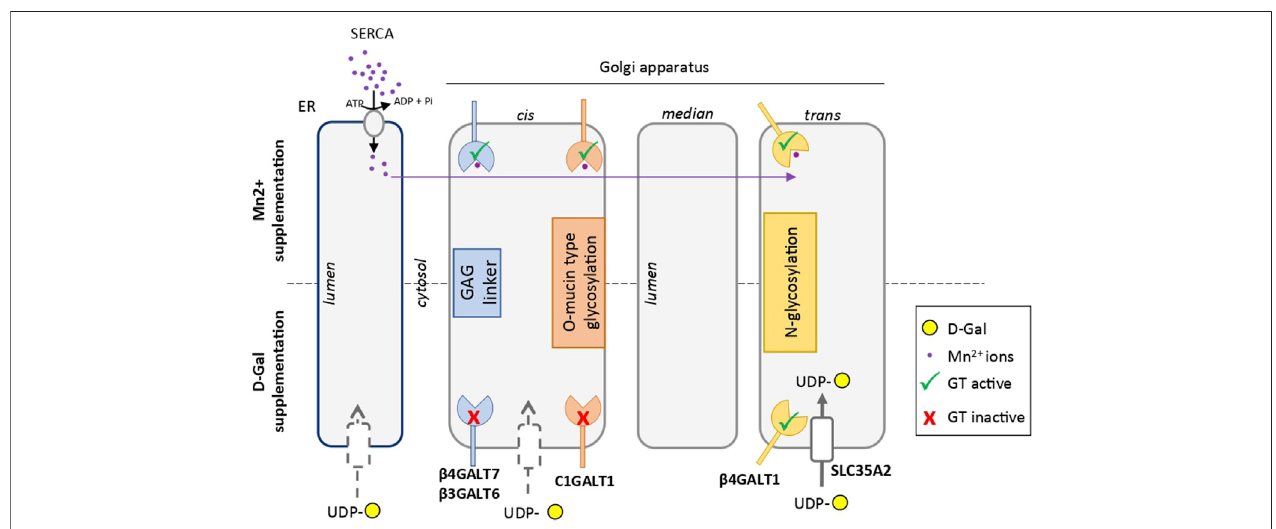
FIGURE 7 | Scheme comparing the hypothetical mechanisms involved in the rescue of glycosylation induced by Mn 2+ and D-galactose in TMEM165 KO cells. Endoplasmic reticulum (ER)andGolgiapparatus cisternae arerepresented. GalactosyltransferasesinvolvedinGAGlinkersynthesis, mucin-type O -glycosylationand N- glycosylation are indicated in blue, red and yellow, respectively. The UDP-Gal transporter SLC35A2 in the vicinity of the catalytic site of β 4GALT1, thus explaining the selectivity of D-Gal for N -linked glycosylation, is represented with a white box in the trans -Golgi. The other putative UDP-Gal transporters in the ER and cis -Golgi apparatusareindicatedbygrey-dottedboxes.TheMn 2+ ionisinpurple.InabsenceofTMEM165andafterMn 2+ supplementation,cytosolicMn 2+ ispumpedbySERCA in the ER lumen and redistributed within the Golgi to sustain, as a cofactor, the different galactosyltransferase activities.